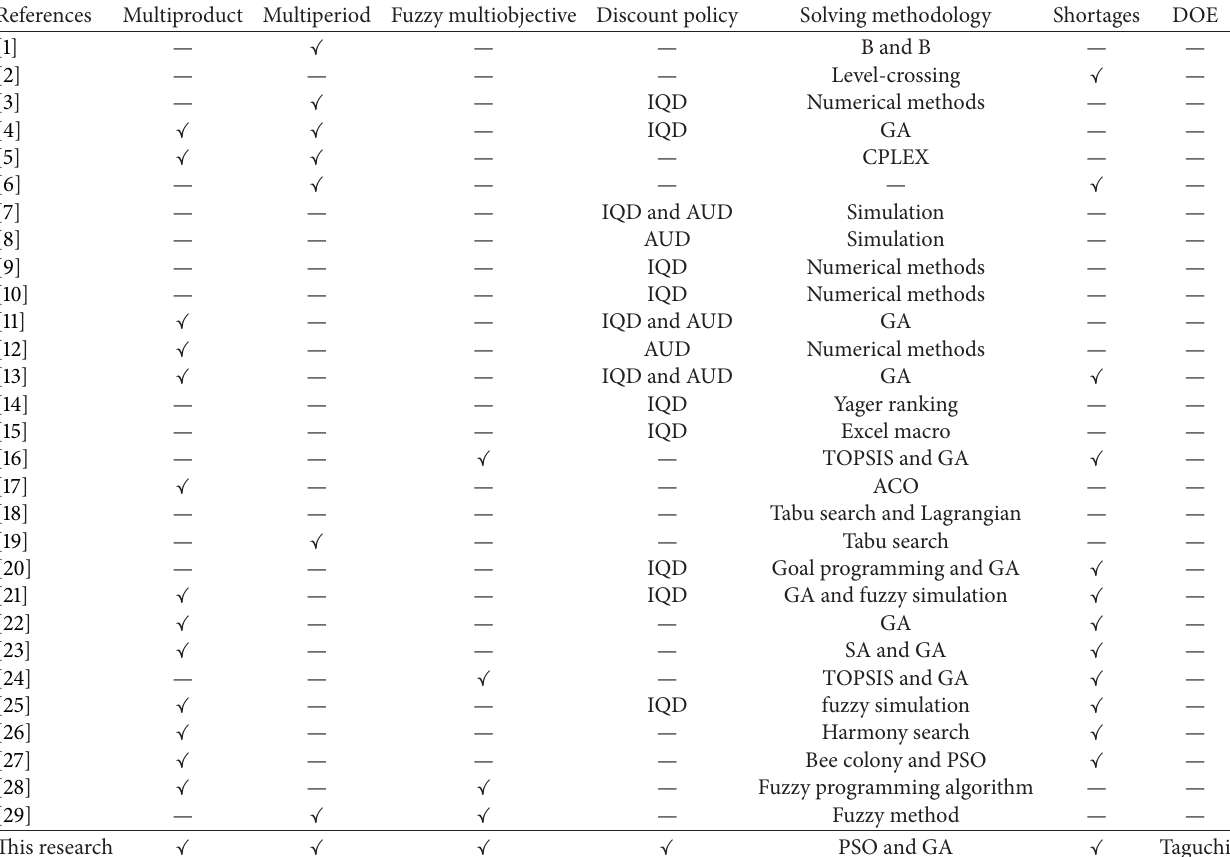
Table 1: Literature review of the related